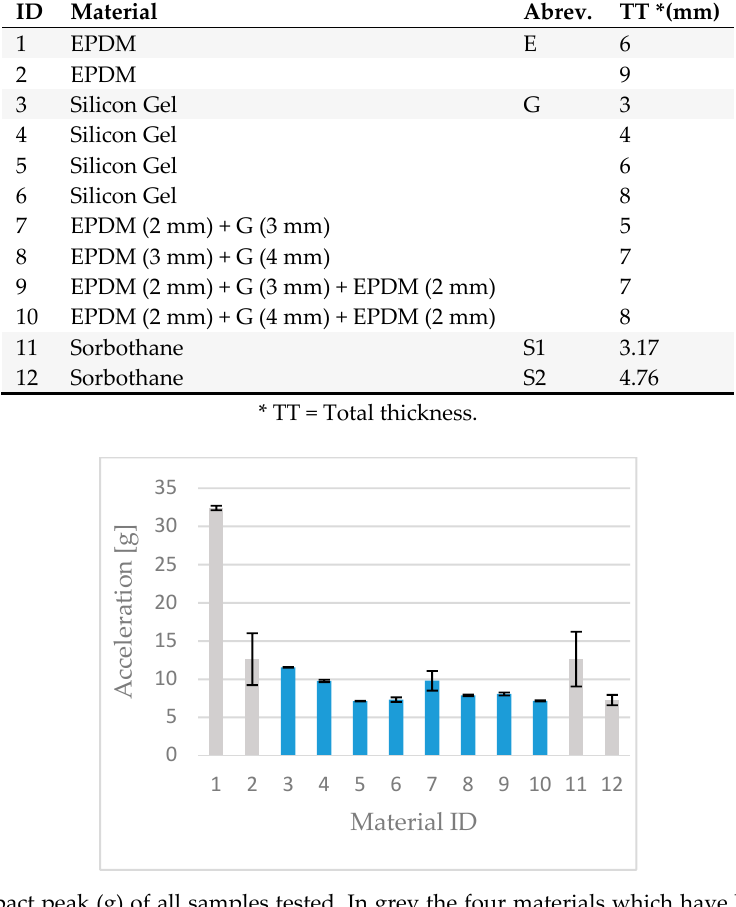
Figure 2. Impact peak (g) of all samples tested. In grey the four materials which have been selected for the succeeding research